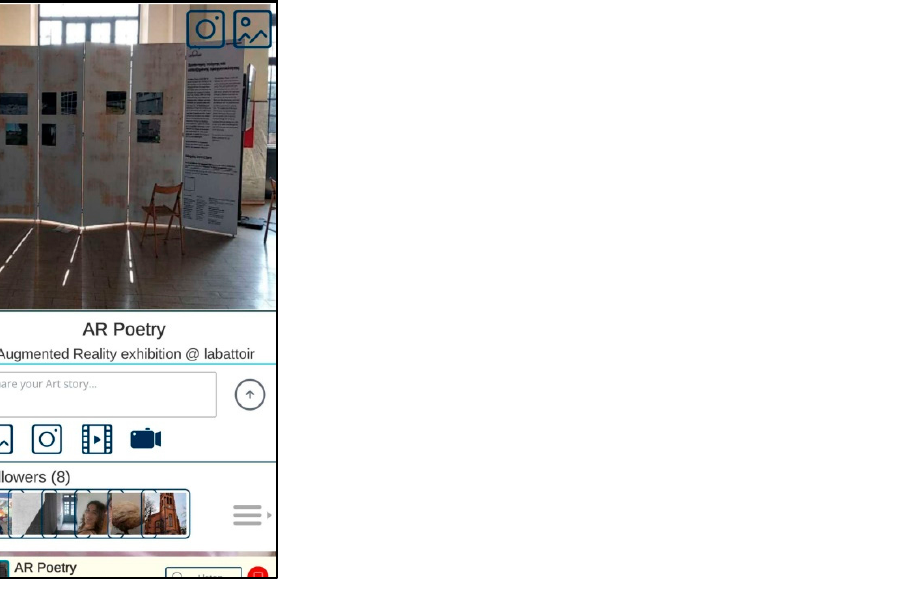
Figure 17. Examples of users’ posts shared regarding the selected AR photo exhibits.